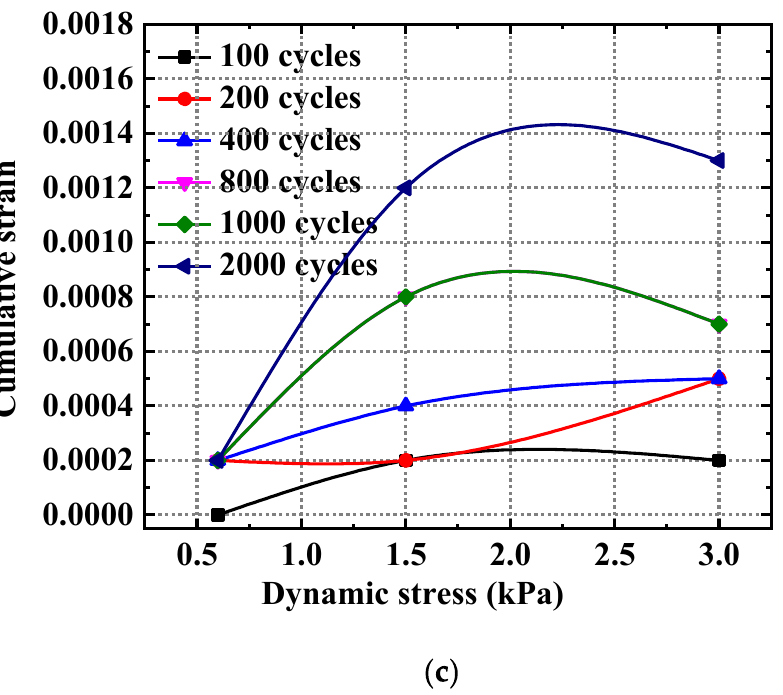
Figure 15. Cumulative-strain variation under different depths. ( a ) Depth = 0.5 m; ( b ) Depth = 1.5 m; ( c ) Depth = 2.5 m.